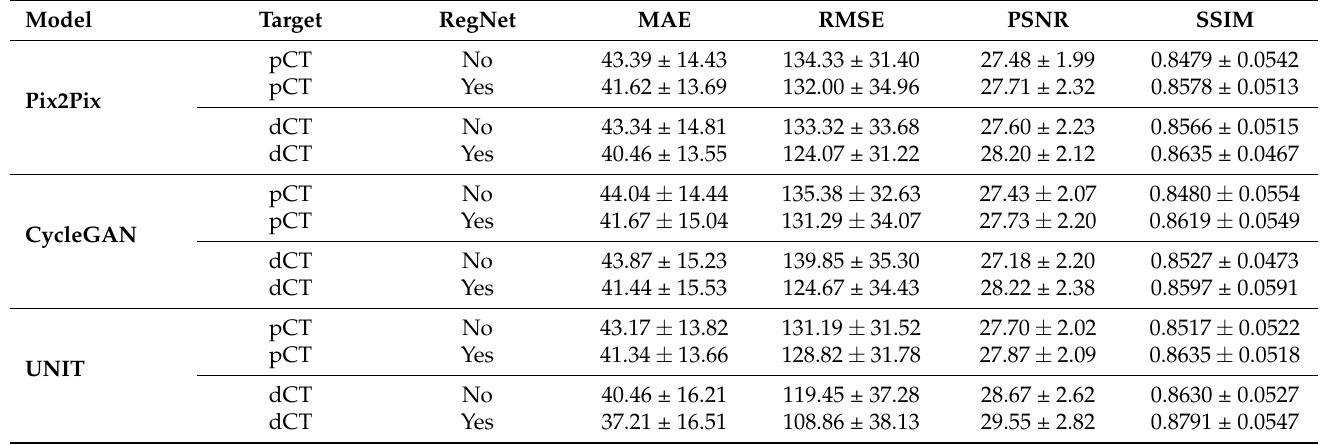
Table 3. Quantitative comparison of sCT generated from Pix2Pix, CycleGAN and UNIT, with and without RegNet, and with pCT and dCT as the target class.